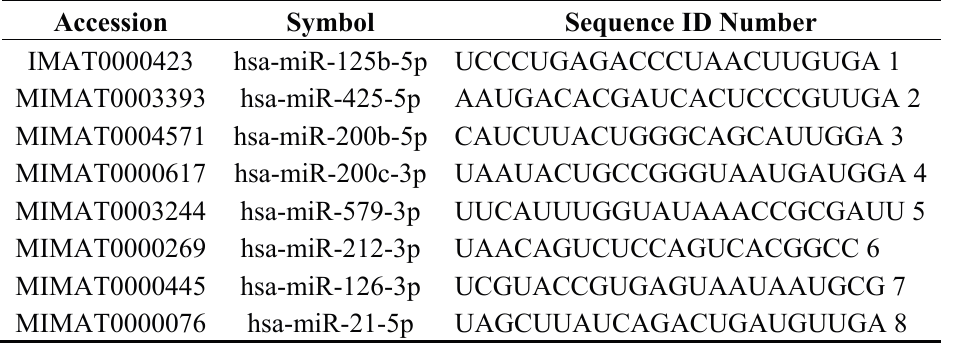
Table 6. miRNA collection: accession number, symbol, sequence, and identification number used in this study of miRNA